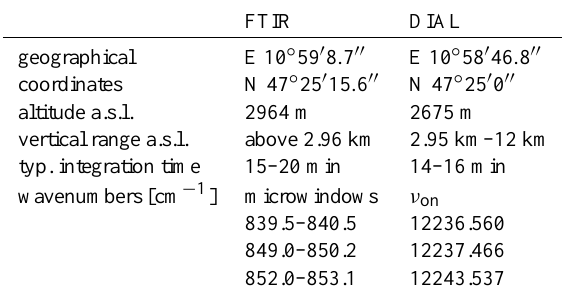
Table 1. Specifications of the FTIR and the DIAL on Mt.